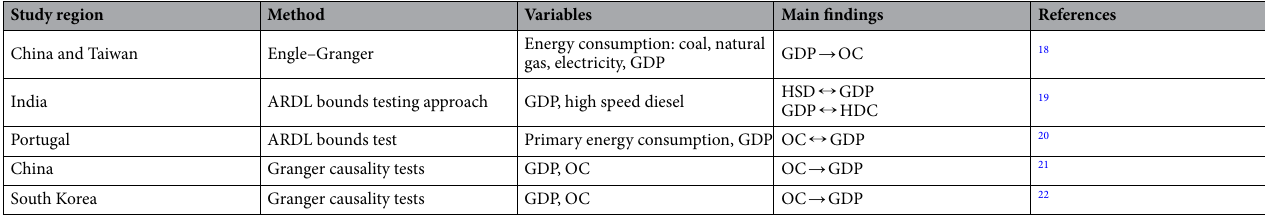
Table 1. Relationship between energy consumption and economic